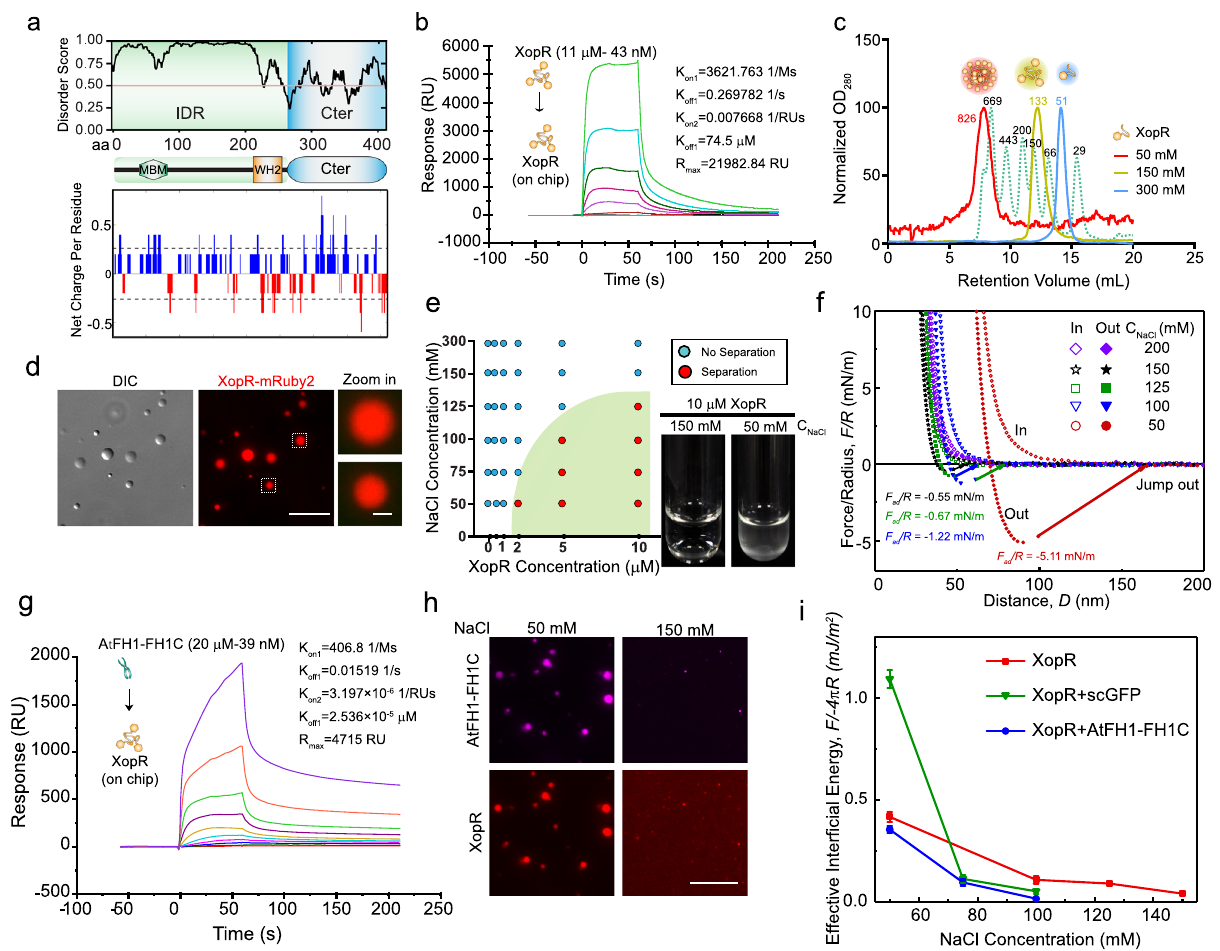
Fig. 2 Biochemical and biophysical characterizations of XopR LLPS. a Schematic diagram of the domains and charge pattern of XopR. IDR (upper panel) and charged residues (bottom panel) were analyzed by IUPRED2 and CIDER, respectively. b Representative SPR sensorgram of the XopR – XopR interaction. XopR at concentrations of 11 μ M to 43 nM fl owed over the chip with immobilized XopR. Binding parameters were generated using bivalent model. c Size exclusion chromatography of XopR at the indicated concentration of NaCl solution using Superdex 200 GL 10/300 Increase. The green dashed curve represents the elution pro fi le of standard protein markers. d Liquid-liquid phase separation (LLPS) of XopR. XopR (10 μ M, 10% XopR-mRuby2) was prepared in 50 mM NaCl solution, pH = 7.4, for 10 min before imaging. e XopR phase diagram was generated using ten images for each condition. Turbidity tests of XopR in solution are shown at the indicated NaCl concentration. f Typical force-distance pro fi les measured during approaching (open symbols) and separation (solid symbols) of the mica surfaces with an injected mixture of XopR coacervate as a function of the concentration of NaCl. g Representative SPR sensorgrams for XopR (on-chip) and AtFH1-FH1C, which were injected at concentrations of 20 μ M to 39 nM. Binding parameters were generated using bivalent model. h Complex coacervation of XopR-AtFH1-FH1C in the low salt buffer (20 mM HEPES, 50 mM NaCl, pH = 7.4) and physiological buffer (20 mM HEPES, 150 mM NaCl, pH = 7.4). XopR (5 μ M, 10% XopR-mRuby2) and AtFH1-FH1C (5 μ M, 10% Alexa647-AtFH1-FH1C) were mixed for 10 min before imaging. i Effective interfacial energy of coacervates of XopR (10 μ M), XopR-ScGFP (10 μ M XopR + 10 μ M ScGFP), and three measurements.Scale bar: 10 μ m in d , 1 µ M for magni fi ed images in d , and 10 μ m in h